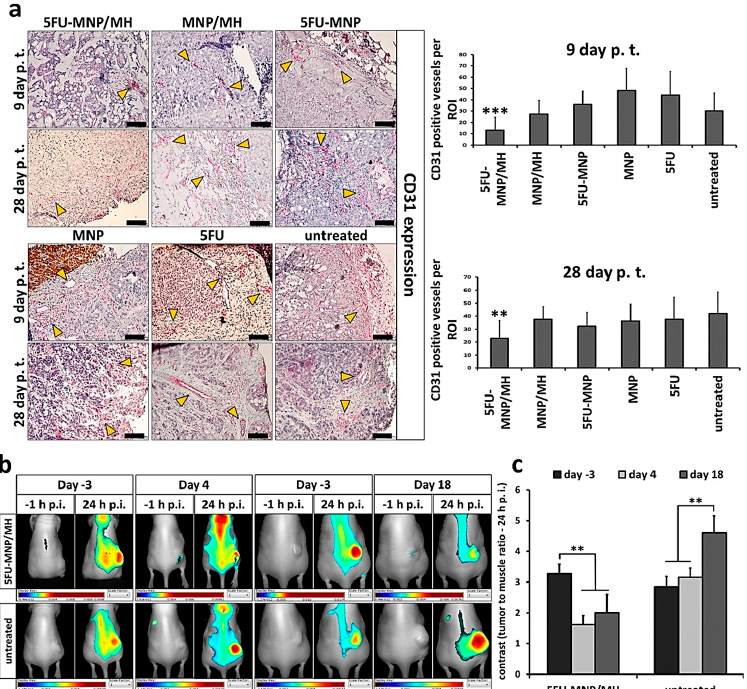
Figure 5. Tumor vascularization is impaired after treatment with the thermo-chemotherapeutic tumor treatment. ( a ) Reduced CD31 expression in tumors treated with the combinatorial therapy (5FU-MNP/MH) compared to the either therapies alone (5FU-MNP or MH). Depicted are representative histological micrographs of tumor tissue slices after immunohistochemical staining as well as semi-quantitative estimations of protein expression ( n = 3 ex vivo experiments). Arrows marked representative CD31 positive vessels. ( b ) Representative light and NIR fluorescence images of tumor bearing animals after injection or not with 5FU-CS-MNPs (CS- and 5FU-CS-coated, 0.25 mg Fe per 100 mm 3 tumor tissue and 0.22 to 0.55 mg 5FU per kg body weight) and exposure or not to AMF (60 min at H = 15.4 kA/m, f = 410 kHz). − 1 h: before injection of the optical probe IRDye ® 800CW RGD targeting α v β 3 integrin, 24 h: time after injection of the optical probe. ( c ) Fluorescence contrast (tumor-muscle ratio) of the IRDye ® 800CW RGD optical probe at 24 h after injection, − 3, 4, 18 days: time points with reference to the first tumor therapy. Images were obtained using the Maestro™ in vivo fluorescence imaging system. IRDye ® 800CW RGD injection concentration: 1 nmol per 25 g of mouse body weight; MH: magnetic hyperthermia; MNP; magnetic nanoparticle; 5FU: 5-fluorouracil; p.i.; post injection. Scale bar = 100 µm for histological micrographs. Bars represent the mean ± standard deviation of n = 28 for CD31 expression analysis and the mean ± standard error of n = 5 (days 4 and 18 post first tumor therapy), and n = 10 (day − 3 post first tumor therapy). Independent two-sample t-test indicated significant differences between the groups (** p < 0.01 and *** p < 0.001).